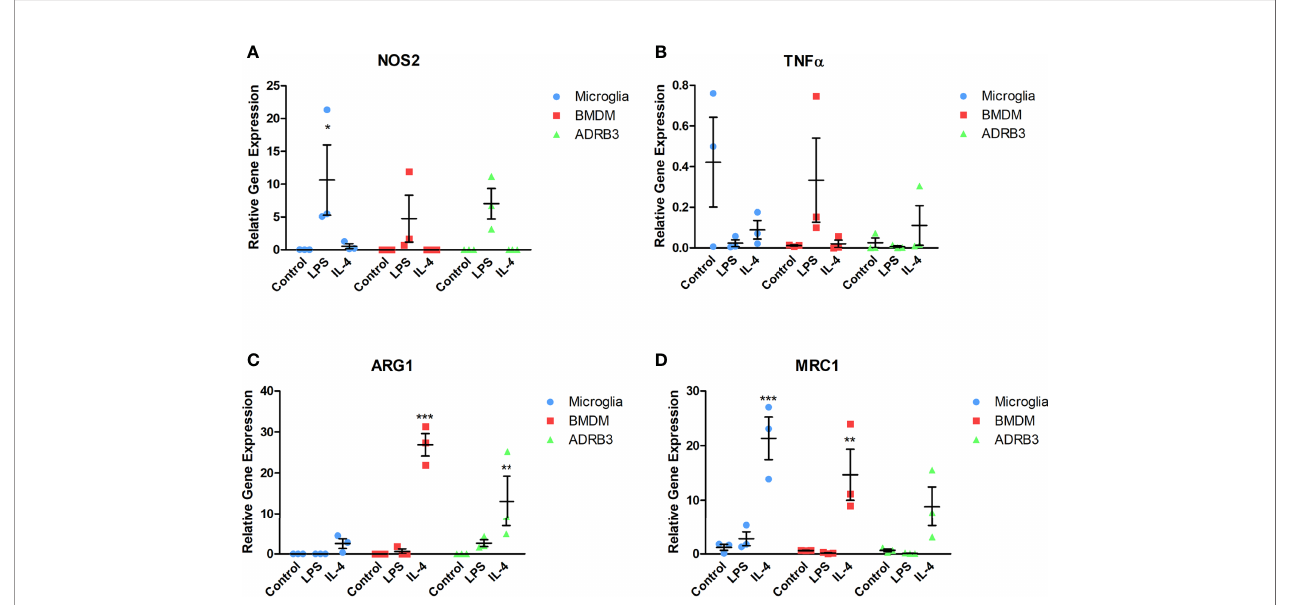
FIGURE 5 | ADR b 3+ cells undergo M1-M2 polarization through response to cytokines in their environment. ADR b 3+ cells, BMDMs, or microglia were isolated and placed in culture in the presence of Il4, LPS, or saline. RNA was isolated 48 hours later, and qRT-PCR was used to quantify genes associated with M1 macrophages (A) Inos, (B) Tnf a , and M2 macrophages (C) Arg1, (D) Mrc1. Signi fi cant differences (p<0.5) were calculated using an ANOVA with Tukey correction. Bars represent the mean of six samples per group. Standard error of the mean (SEM) is shown by the capped vertical line. *p < 0.05, **p < 0.01, ***p <